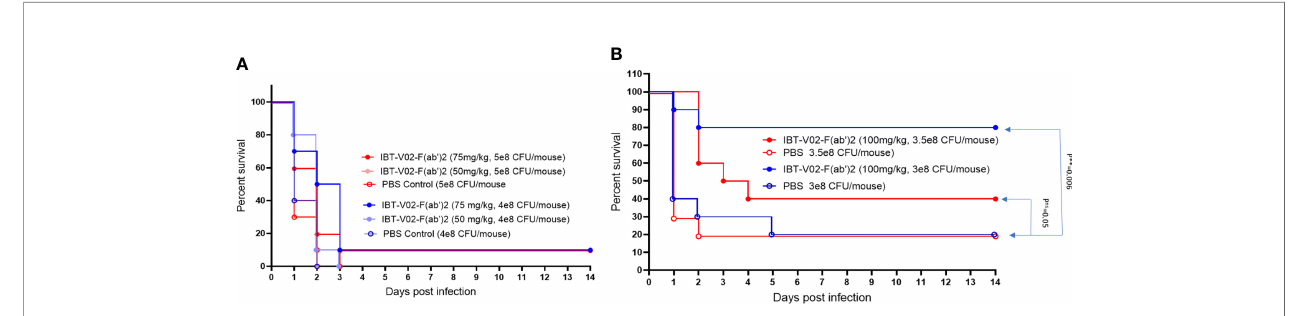
FIGURE 10 | The dose-dependent ef fi cacy studies in BALB/c mice challenged with USA300 (NRS384) in pneumonia model. (A) High challenged dose (5 x 10 8 CFU/mouse and 4 x 10 8 CFU/mouse) (B) Titrated challenge dose (3.5 x 10 8 CFU/mouse and 3 x 10 8 CFU/mouse). The data were analyzed by log-rank (Mantel-Cox) test. ns, P > 0.05; **, P ≤